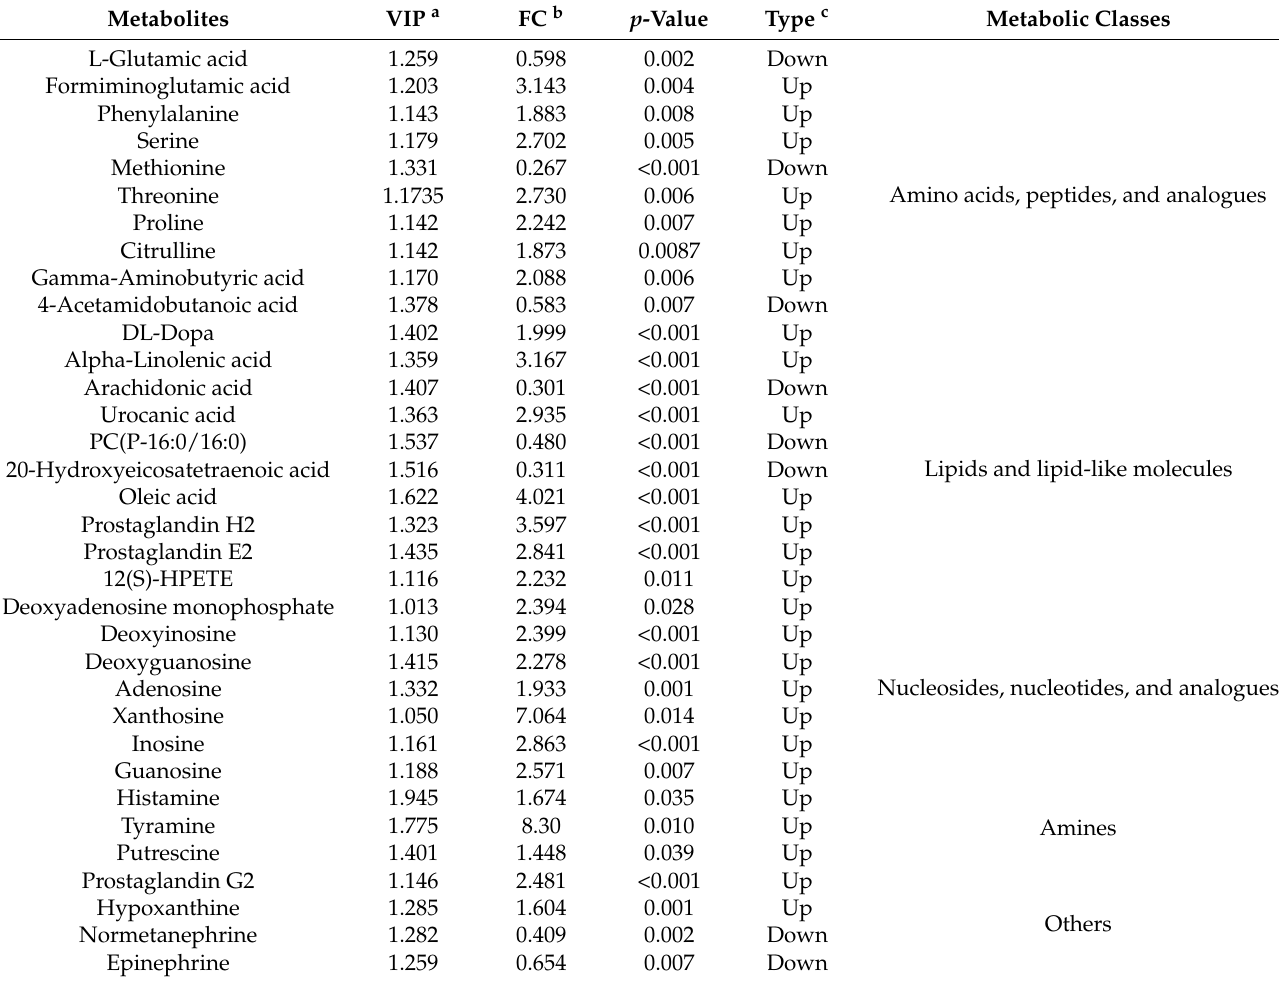
Table 4. Identification of significant differential metabolites in the ruminal fluids of HG and CON yaks.